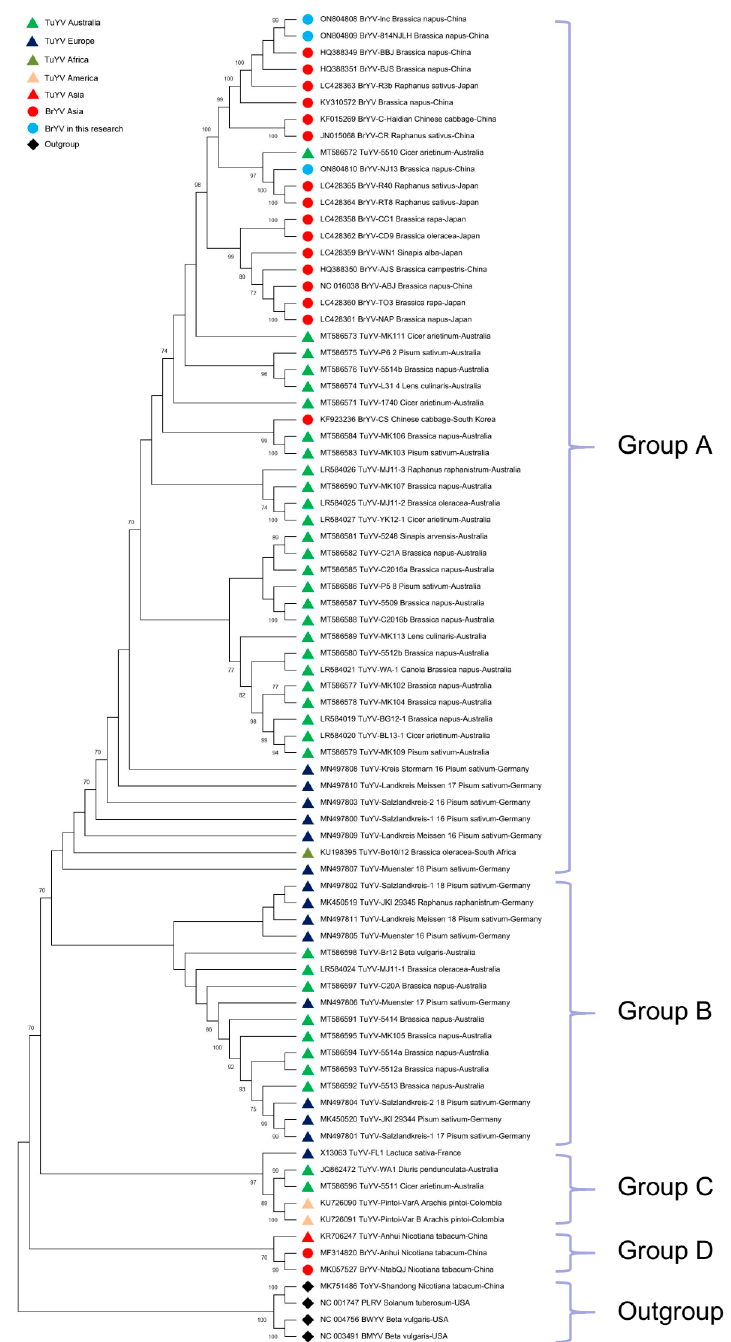
Figure 4. Phylogenetic tree constructed using the available nearly complete nucleotide genome sequences of BrYV isolates ( n = 21) and TuYV isolates ( n = 55). The phylogenetic analysis was derived with maximum likelihood (ML) based on the General Time Reversible (GTR) model, which was selected as the best model of nucleotide substitution based on the Bayesian Information Criterion (BIC) as implemented in MEGA X. Isolates are identified by their GenBank accession numbers, isolate name, host and geographical location (Supplementary Table S2). Bootstrap values of more than 70% (1000 bootstrap repeats) are